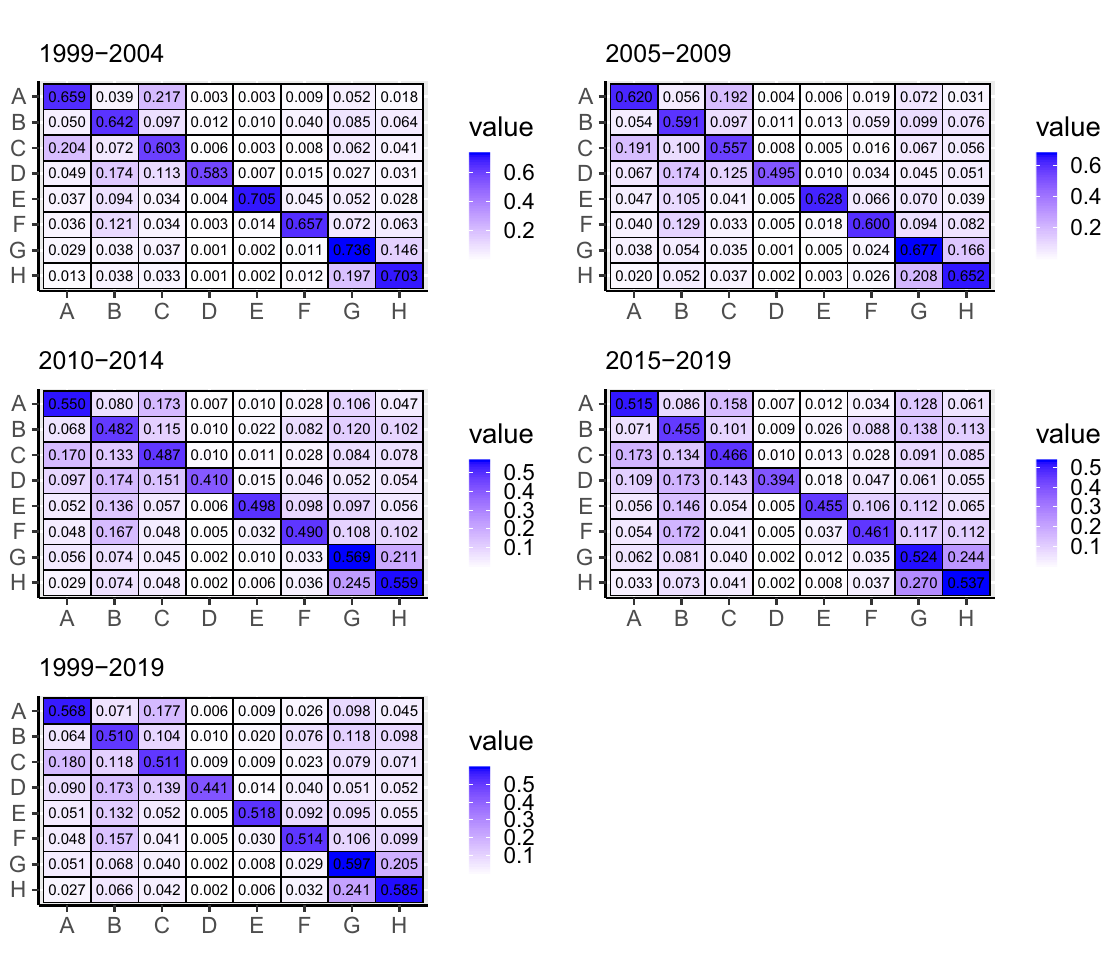
Fig 7. Contingency tables over time by technological field, 1999–2019.